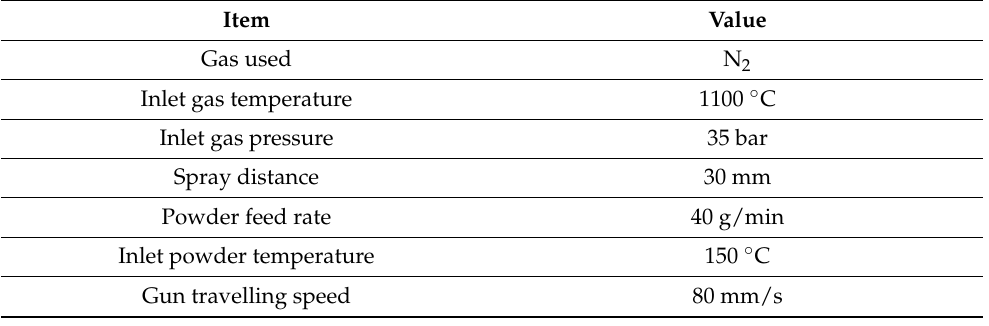
Table 1. High-pressure cold spray process parameters.